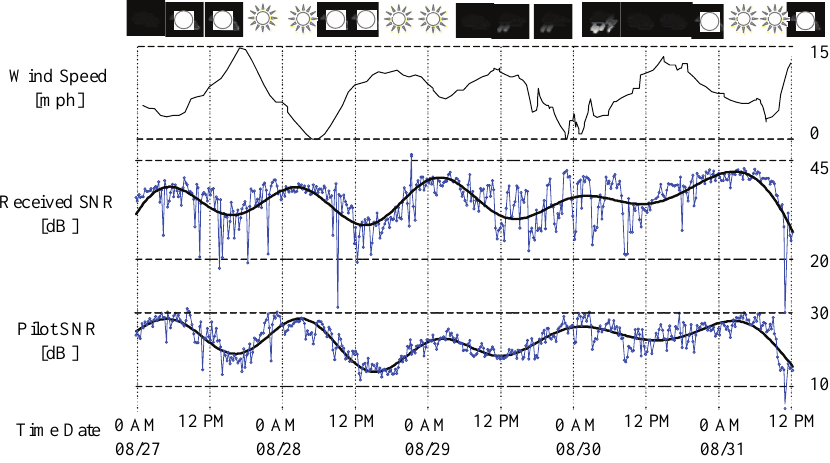
Figure 1. Keweenaw Waterway experiment: Average signal-to-noise rates (SNR) at the